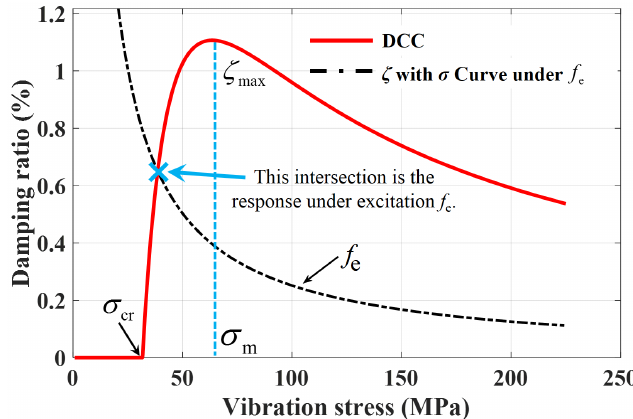
Figure 10. Flow of the damping characteristics of the ring.